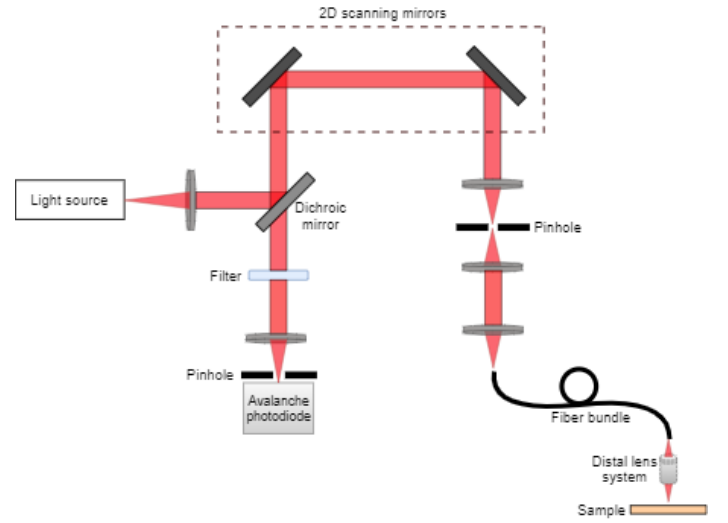
Figure 3. Schematic diagram of a confocal endoscope.